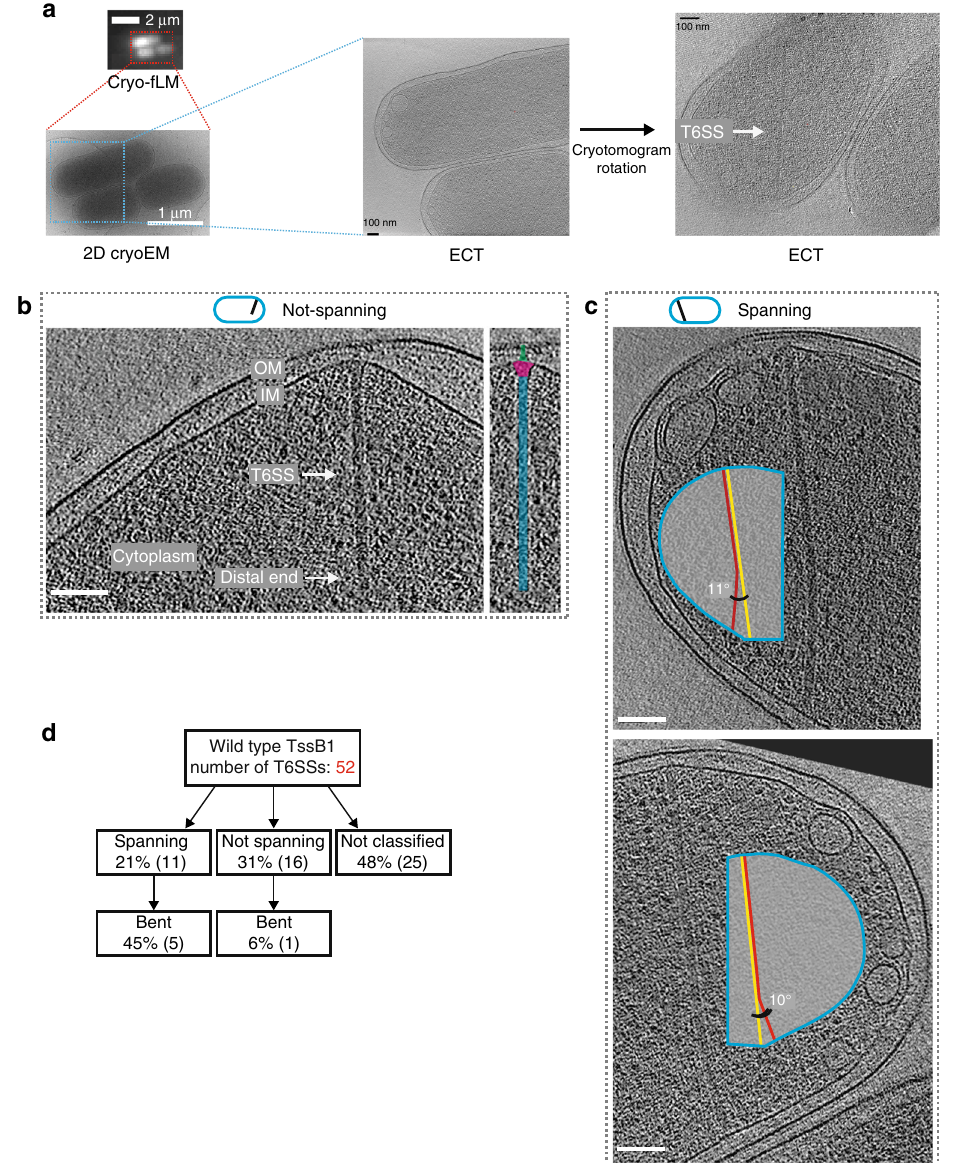
Fig. 4 Hcp1-labeling combined with a correlated cryo-fLM/ECT approach reveals T6SSs that span the cell and are bent. a Shown is the correlative cryo- light/cryo-electron microscopy (CLEM) work fl ow. Cells were cultured, labeled with Hcp1-CouAA by orthogonal translation, and plunge-frozen on an EM grid. The frozen grid was imaged in an FEI CorrSight cryo-light microscope with a 40× air objective (example shown, cryo-fLM) to determine coordinates of cells that showed Hcp1-CouAA signal (indicating extended T6SSs). The grid was subsequently transferred to a cryo-transmission EM. Cells were located by 2D imaging at low magni fi cation (2D cryoEM) and imaged by ECT (two different cryotomographic slices are shown). b , c The orthogonal translation system was used to identify extended T6SSs on a plunge-frozen EM grid. Candidate cells were imaged by ECT. Besides T6SSs whose distal ends were localized in the cytoplasm ( b ), some T6SSs spanned the entire cell, with both ends associated with the IM ( c ). The spanning structures were frequently bent (indicated by insets). Note that the direction of bending enabled the structures to approach both the IMs at an angle closer to 90°. Schematics on top indicate the viewing angle and approximate orientation of the T6SS in the cell. Scale bars: 100 nm. Thickness of tomographic slices: 21.6 nm. d Diagram quantifying the classi fi cation of imaged T6SSs. Note that bending was primarily observed for spanning structures. T6SSs for which the missing wedge prevented from reliable classi fi cation were categorized as “ not classi fi ed